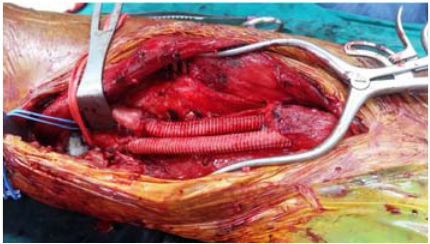
Figure 4: Intraoperative findings of the 2nd case. Chronictraumatic AVF and part of superficial femoral artery and femoral vein was resected. Interposition Dacron graft was